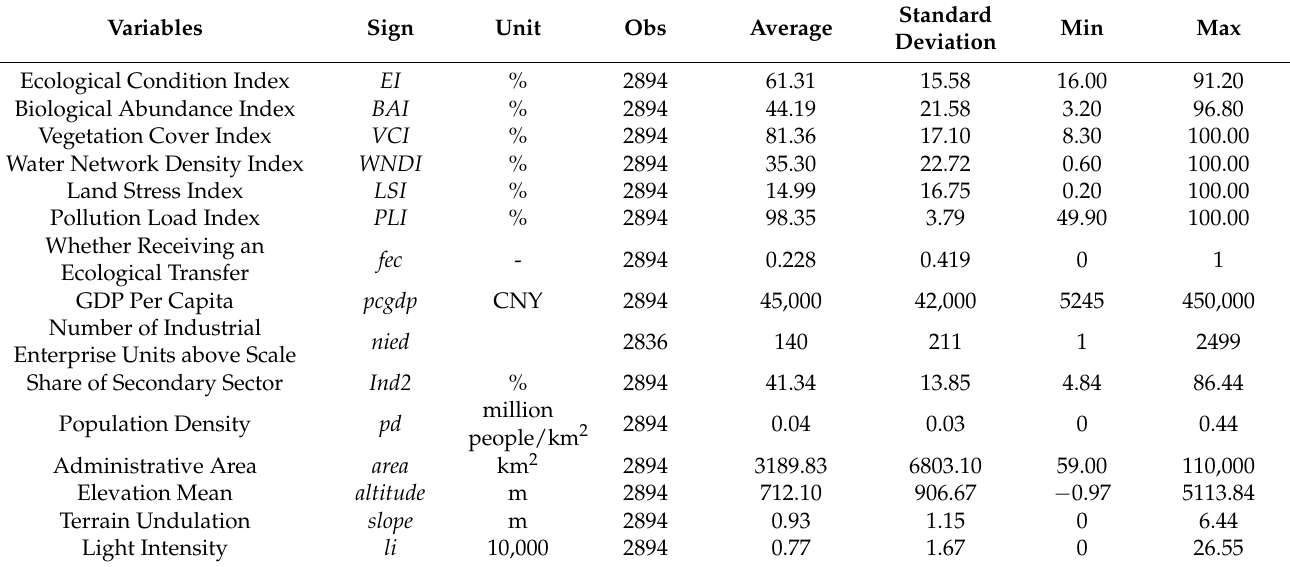
Table 1. Descriptive statistics of each